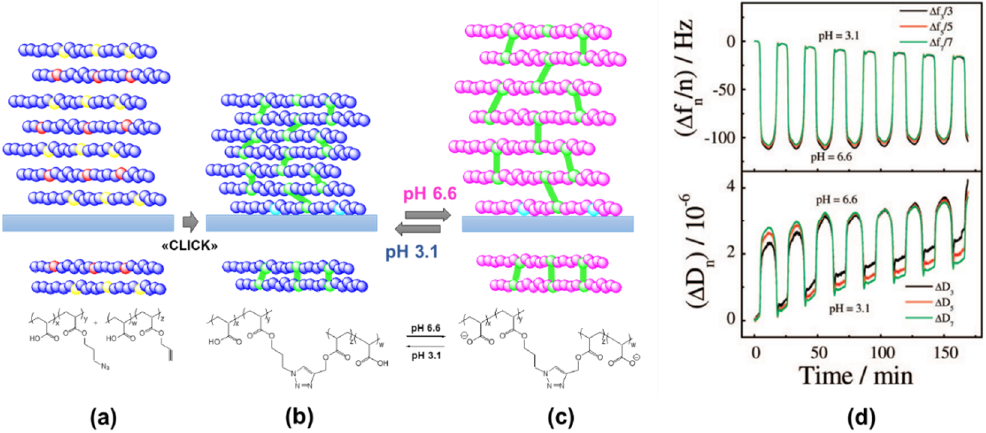
Figure 3. ( a – c ) Chemical structure and schematic representation of the pH-oscillating layer-by-layer assembly, crosslinked with a click chemistry approach. ( d ) Corresponding frequency and dissipation shifts monitored by QCM-D. Reproduced with permission from [66], American Chemical Society, 2008.